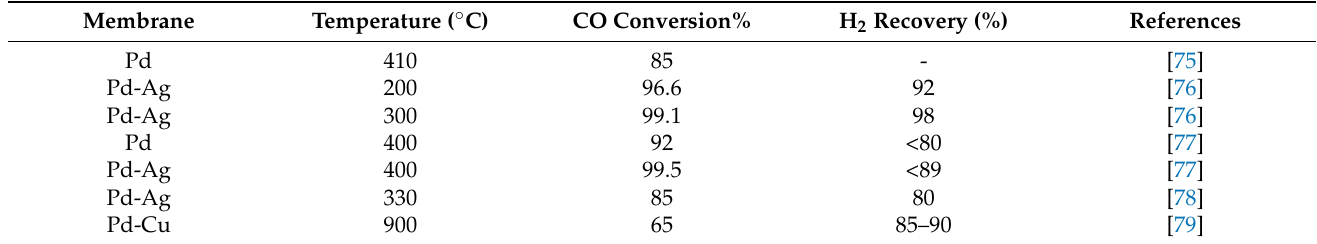
Table 2. Metal membrane reactors are applied in WGS